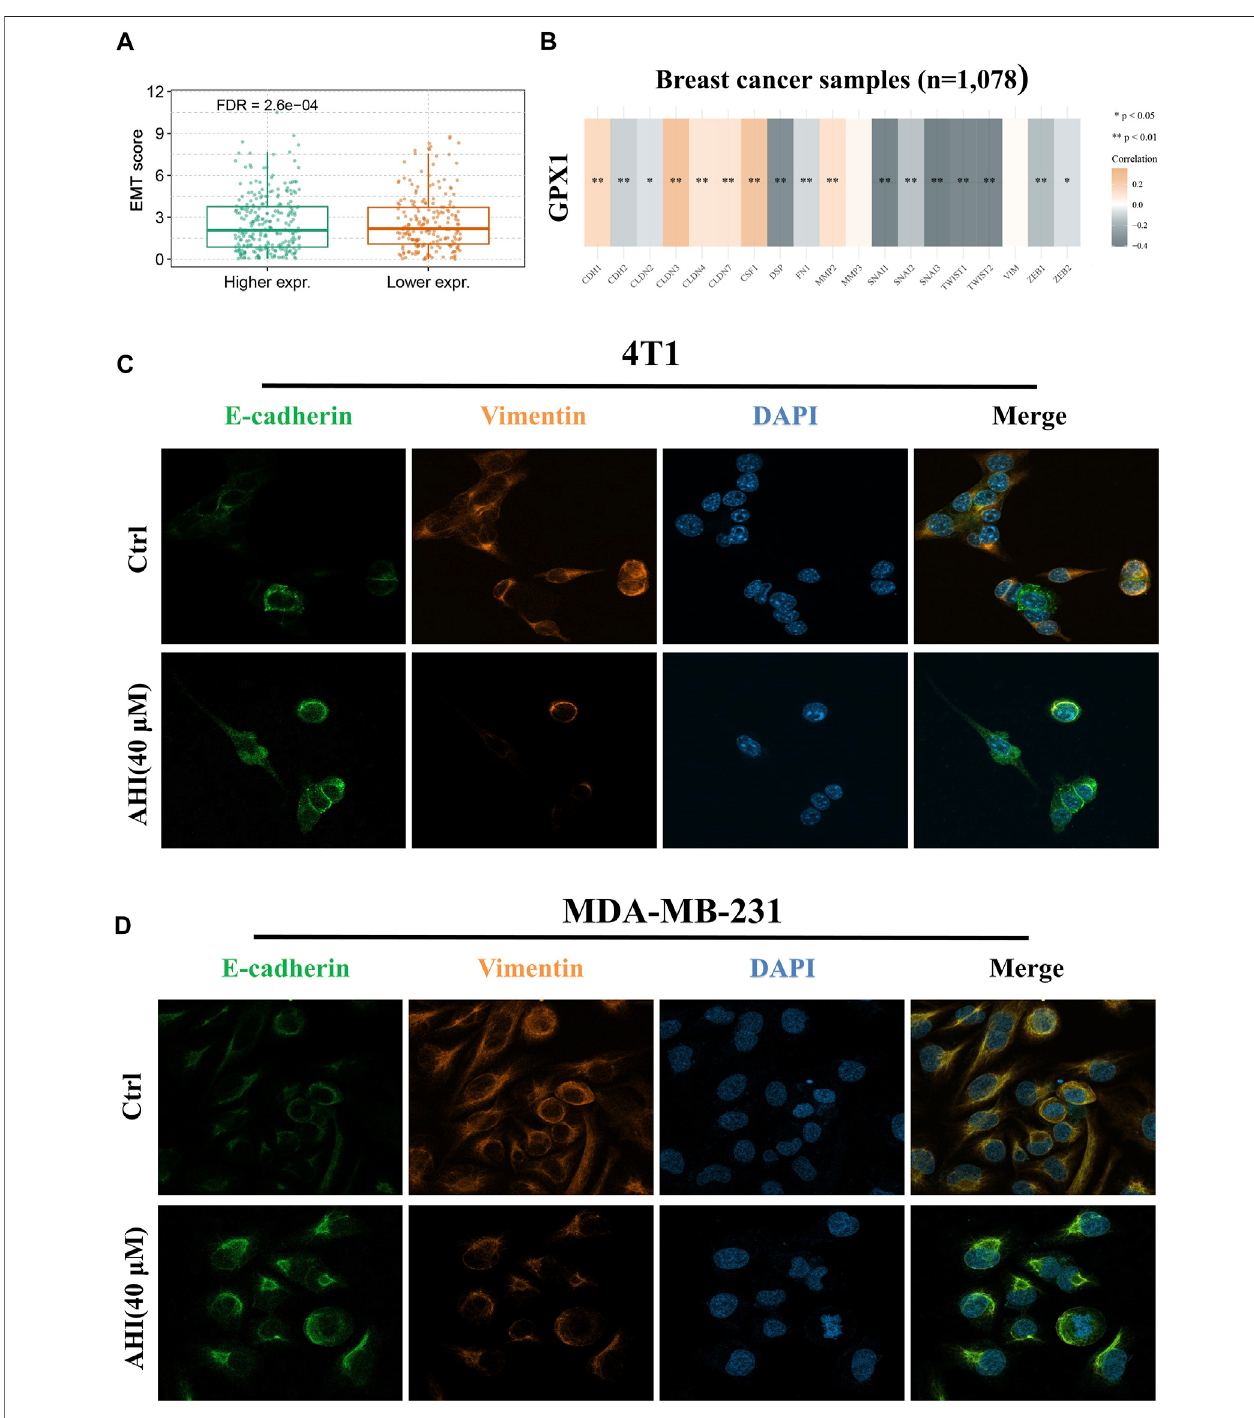
FIGURE 6 | Identi fi cation of AHI-inhibited EMT by enhancing GPX1 expression. (A , B) Relationship between GPX1 expression and EMT. (C , D) AHI signi fi cantly increased E-cadherin (green fl uorescence) and decreased vimentin (orange fl uorescence) expression ( × 630) by confocal immuno fl uorescence analysis.